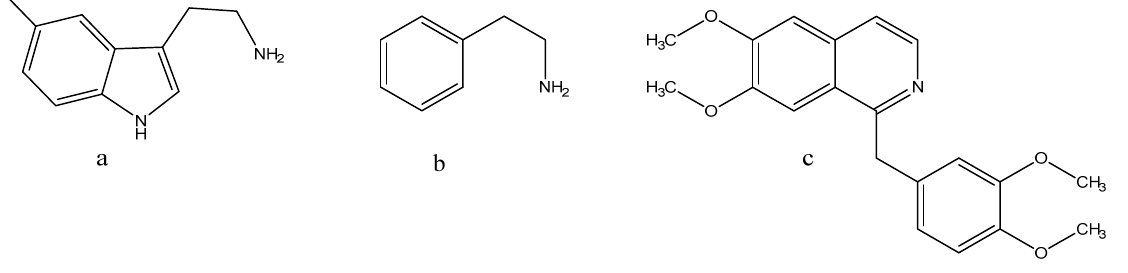
Figure 2. Structures of serotonin (5-HT) ( a ), 2-phenylethylamine ( b ), papaverine ( c ).